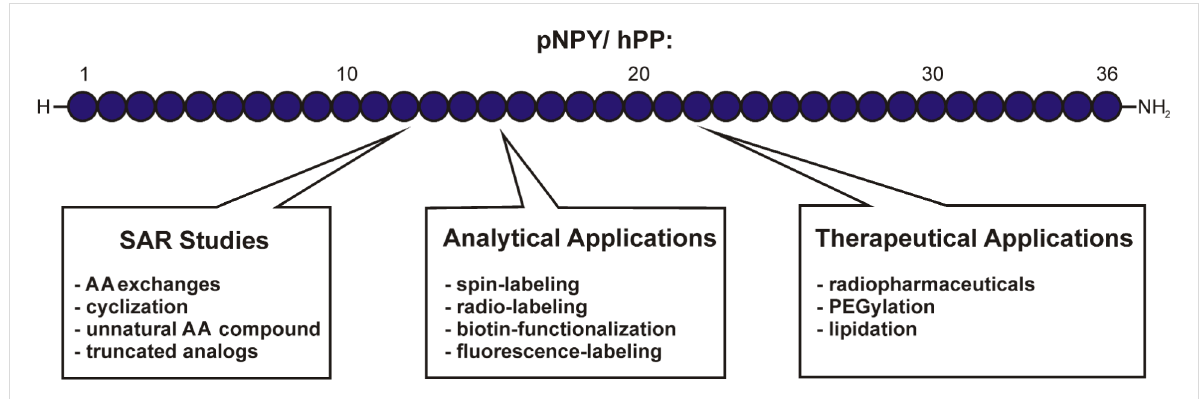
Figure 4: Spectrum of methods for solid phase-synthesized peptides. AA: amino acid, SAR: structure–activity relationship.